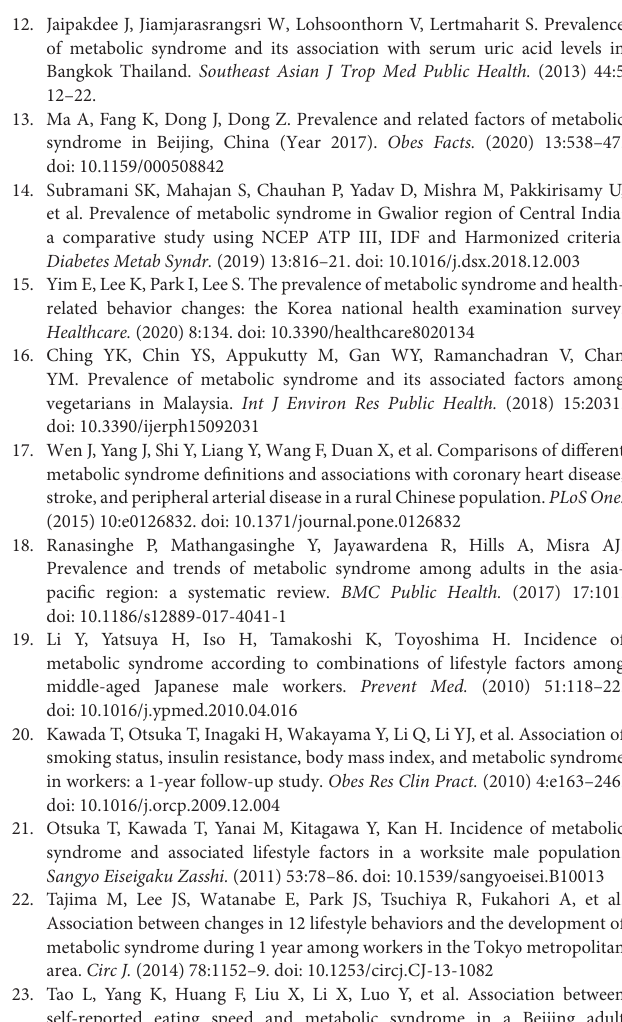
Supplementary Table 2 | Assessment of the quality of 20 cross-sectional studies by the Agency for Healthcare Research and Quality (AHRQ) scale.